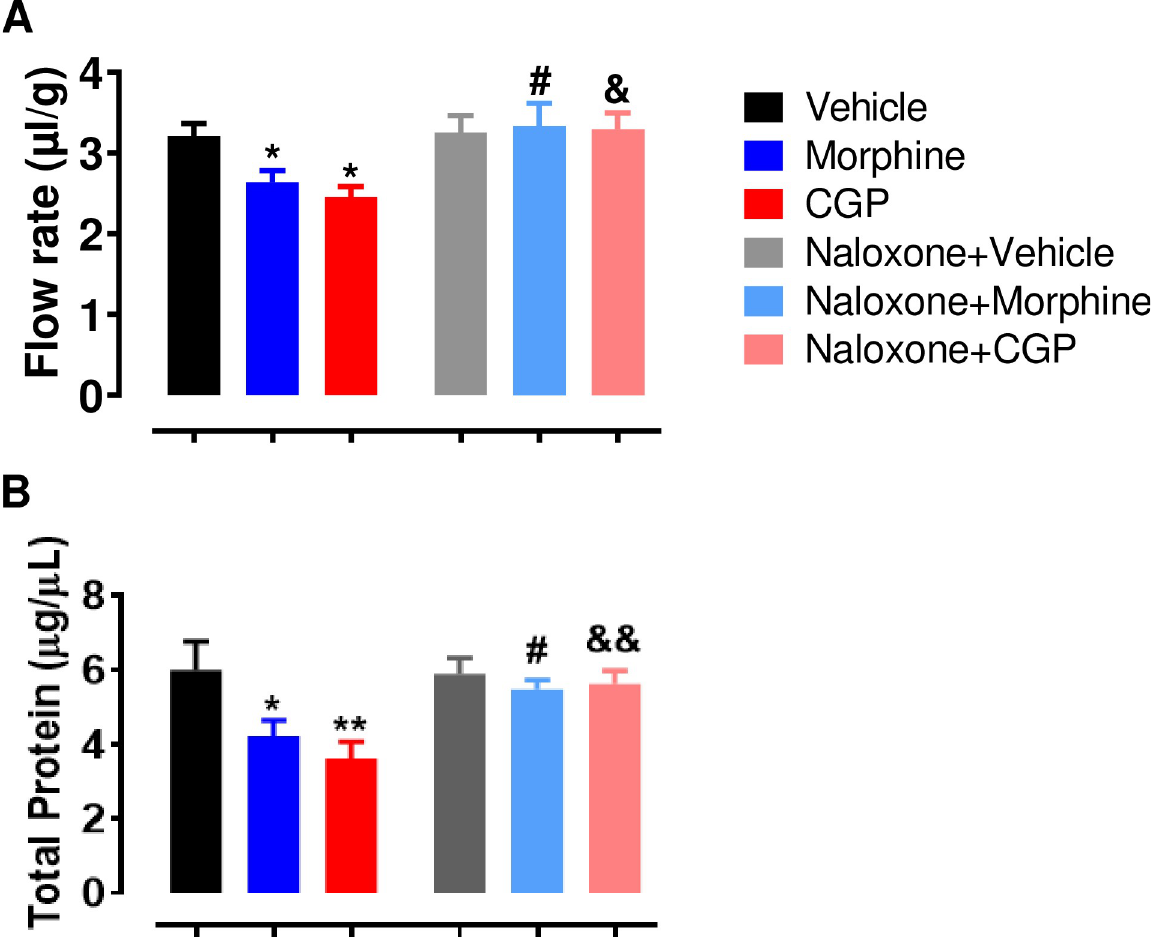
Fig 2. Salivary flow of Swiss mice and salivary total protein concentration after acute treatment with vehicle, morphine or CGP in the presence or absence of naloxone. CGP, Cyclo-Gly-Pro. Naloxone (15.3 μ mol kg -1 , i.p.), an opioid receptor antagonist, was administered 15 minutes before treatment with vehicle, morphine or CGP. One hour after treatment, parasympathetic stimulation was performed for salivary secretion through pilocarpine injection (2 mg kg -1 , i.p.) and total saliva was collected for 10 minutes from the oral cavity. (A) Salivary flow was expressed as salivary secretion per gram of glandular tissue ( μ l/g tissue), equivalent to the ratio of the volume of salivary secretion and the weight sum of glandular parotid and submandibular. (B) Salivary total protein concentration was expressed as μ g/ μ L. Results are represented as mean ± SEM of 6–9 animals; � P < 0.05 vs. vehicle; # P < 0.05 vs. morphine; & P < 0.05 vs CGP. One-way ANOVA, Turkey as post hoc test.